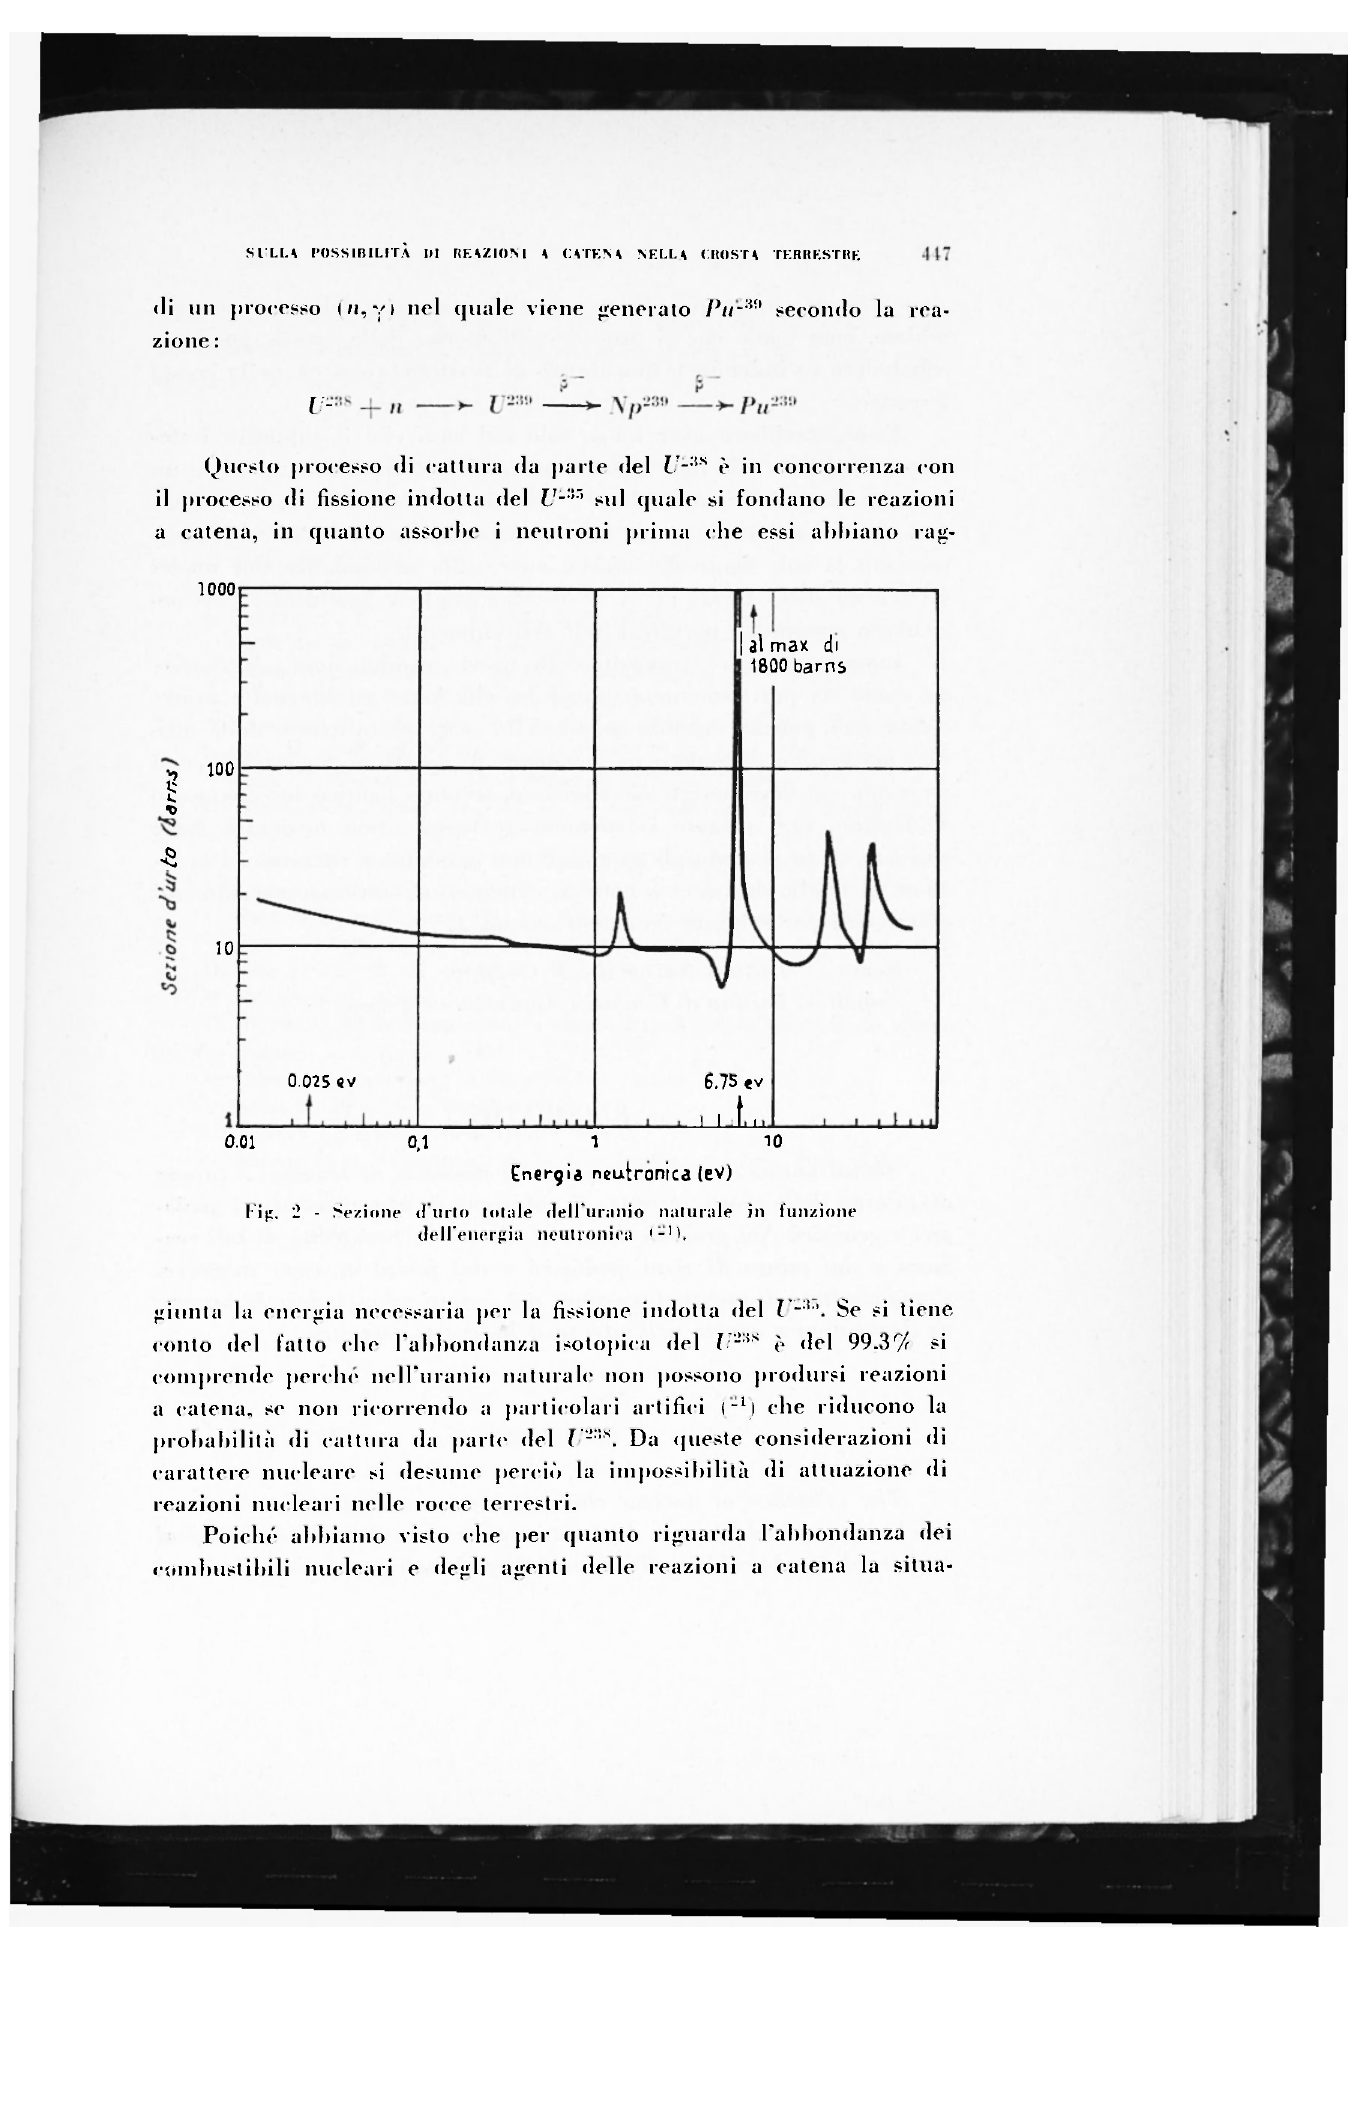
Fig. 2 - Sezione d'urto totale dell'uranio naturale in funzione dell'energia neutronica